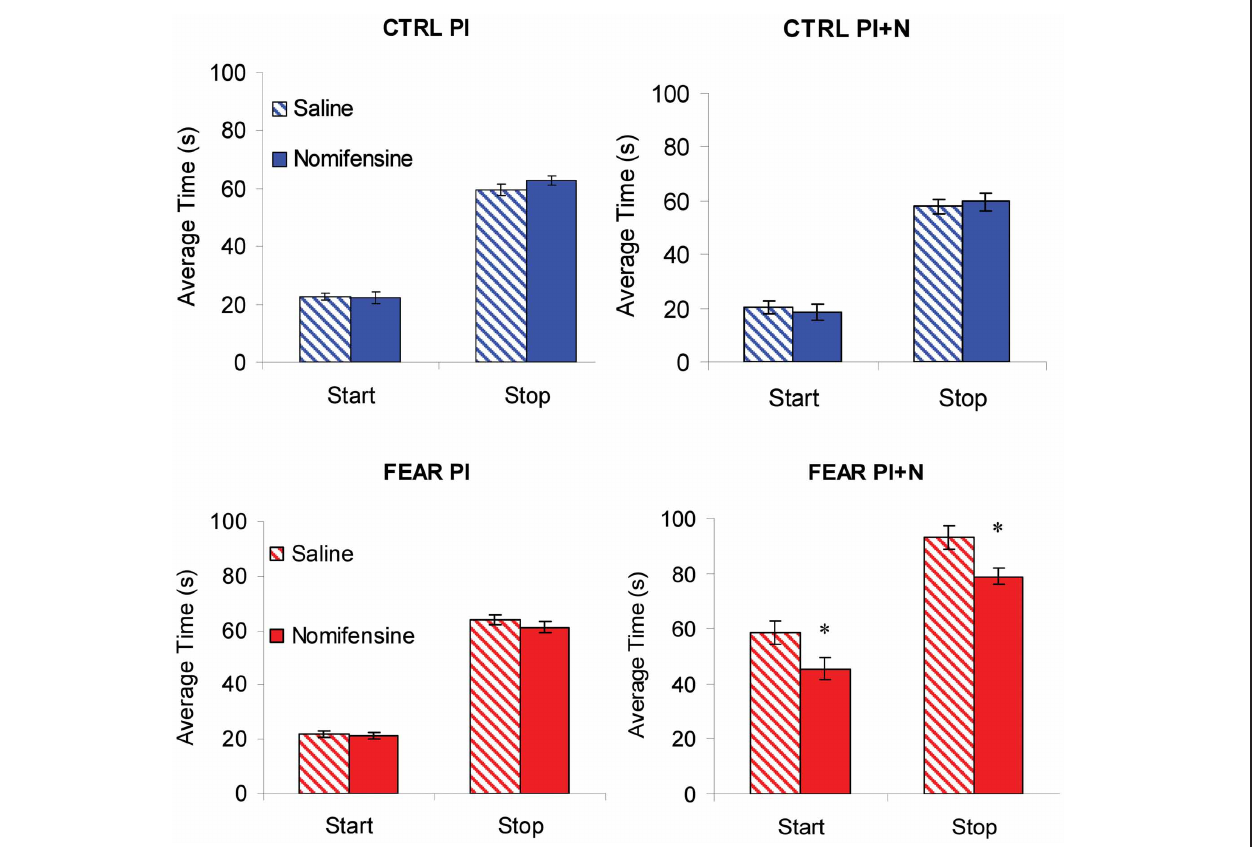
FIGURE 6 | Individual-trial dynamics. Average estimated start and stop times ( ± SEM) in individual trials. Nomifensine reliably reduced both start and stop times only in trials with distracter (PI + N) and only when the noise distracter is emotionally charged (FEAR rats). ∗ p < 0 .